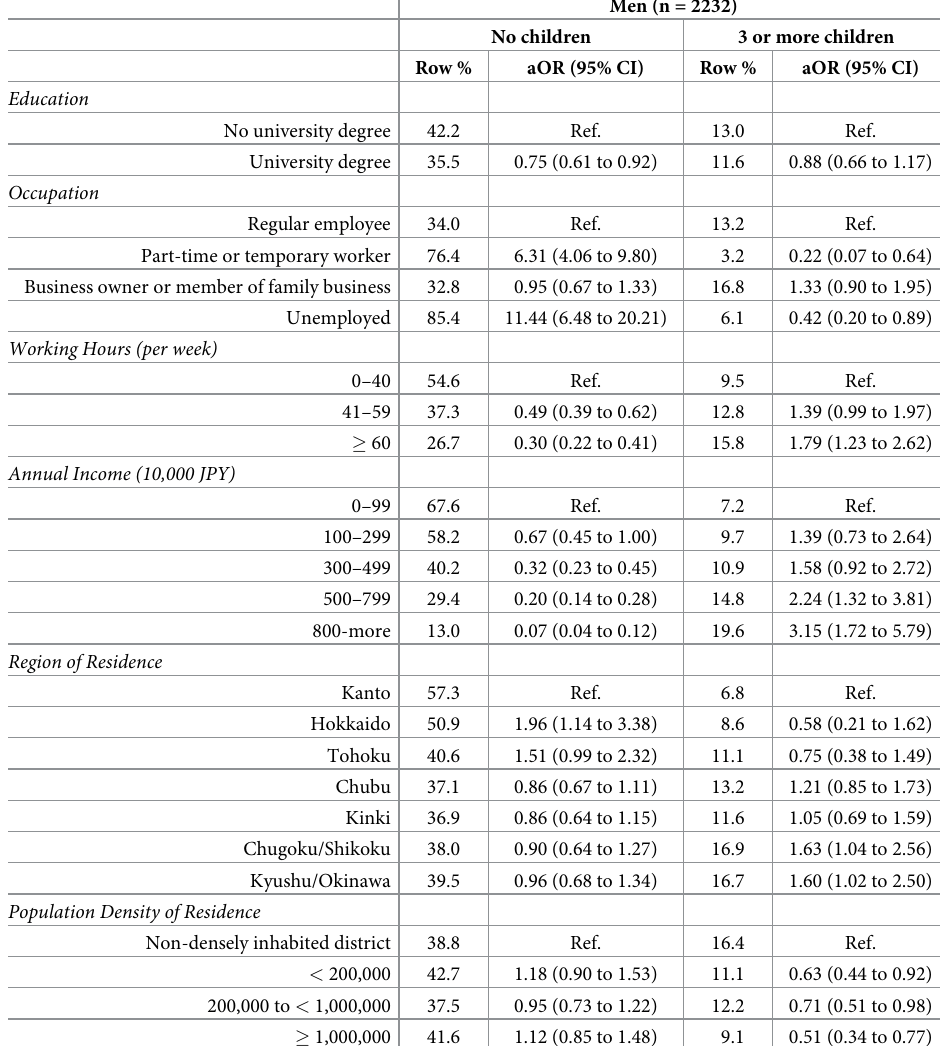
Table 1. Association of sociodemographic factors with childlessness (having no children) and having 3 or more children among men born